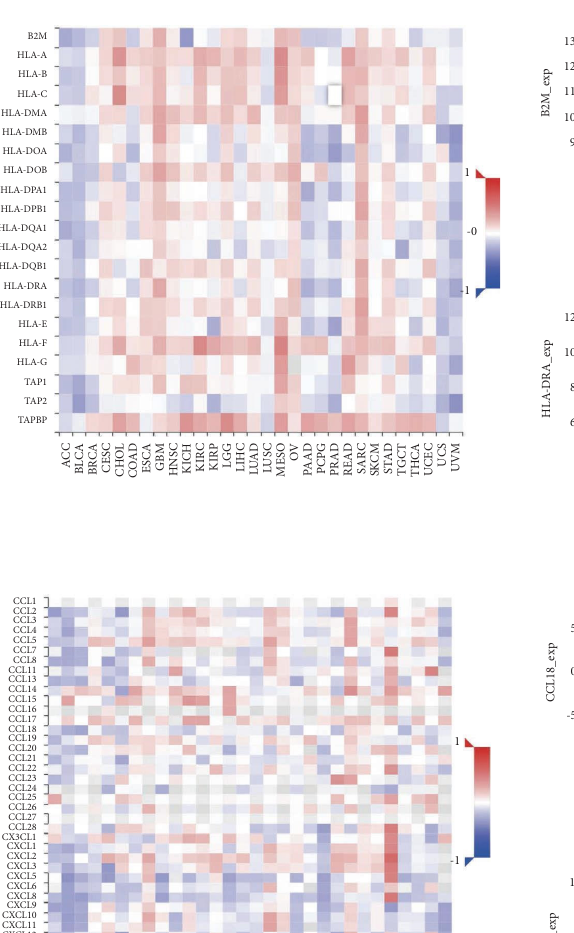
MYL5_exp Spearman Correlation Test: rho = -.027, p = 1.12e-19 (e) Figure 8: